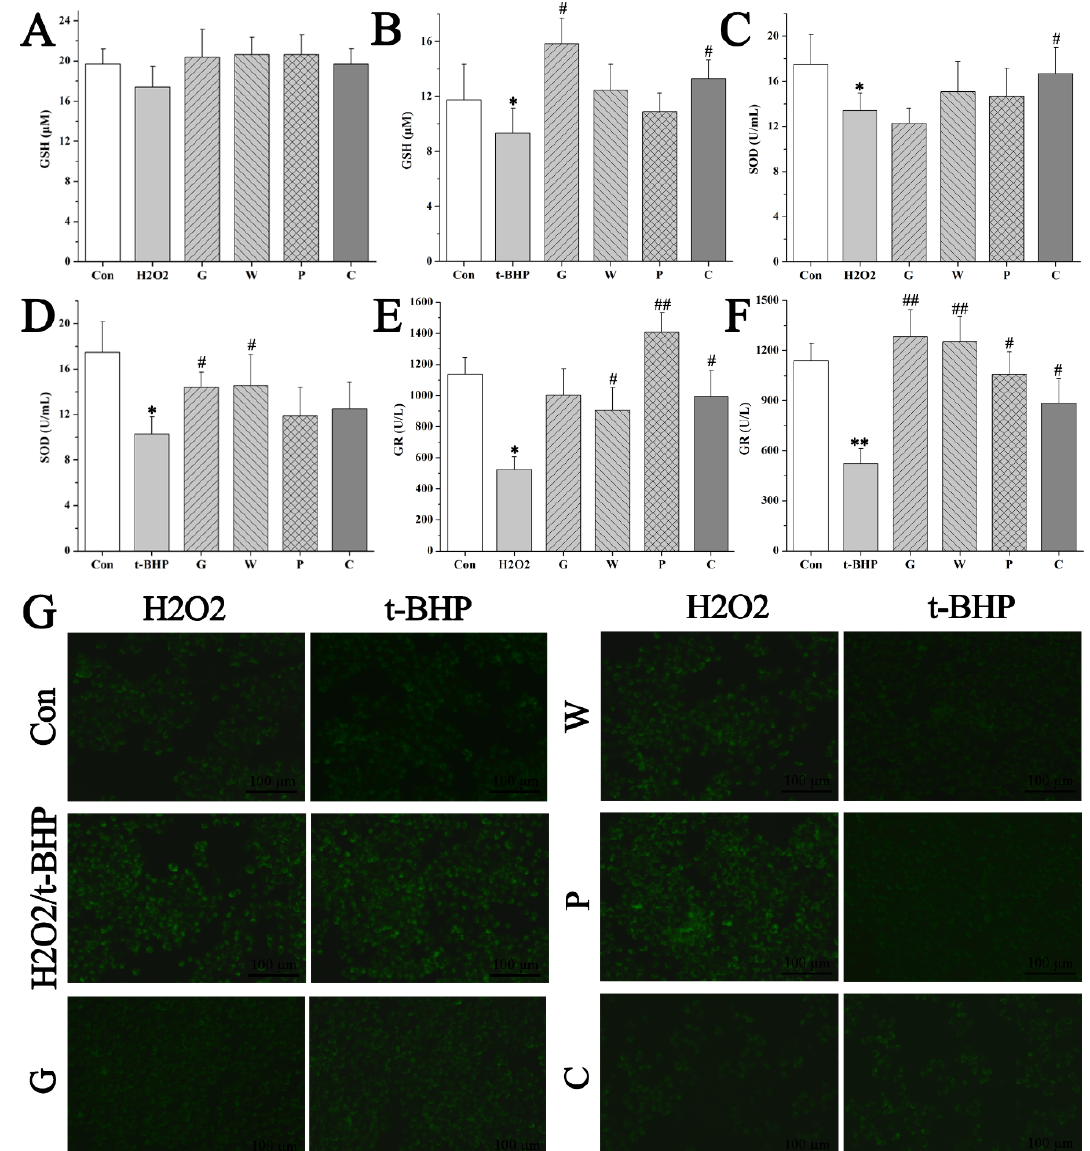
Figure 3. Efficacy evaluation of the crude and the processed Curcuma zedoaria on reactive oxygen species (ROS) related to oxidative damage by L02 assays . ( A – F ) The cellular glutathione (GSH), superoxide dismutase (SOD), and glutathione reductase (GR) levels of 55 μM H2O2 or 40 μM t-BHP model and/or the crude and the processed Curcuma zedoaria (83.33 mg/mL), respectively. (G) Morphological observation and relative fluorescence intensity of L02 cells induced by 55 μM H2O2 or 40 μM t-BHP and/or the crude and the processed Curcuma zedoaria (83.33 mg/mL) by ROS assay under the fluorescence microscope (100×). Con, control group treated with phosphate buffered saline (PBS); H2O2/t-BHP, model group treated with 55 μM H2O2 or 40 μM tertbutyl hydfroperoxide (t-BHP); G, W, P, C, cells treated with Curcuma kwangsiensis S. G. Lee et C. F. Liang, Curcuma wenyujin Y. H. Chen et C.Ling, Curcuma phaeocaulis Val., and vinegar-processed Curcuma zedoaria at doses of 83.33 mg/mL, respectively. The fluorescence reflected ROS levels. The most representative fields are shown. ANOVA with the post hoc test was used to calculate the significance of the differences, *, and ** represents p < 0.05, and p < 0.01 compared with the control group; #, and ## represent p < 0.05, and p < 0.01 compared with the model group, respectively. All experiments were performed three times, and the results are expressed as the mean ± S.D.